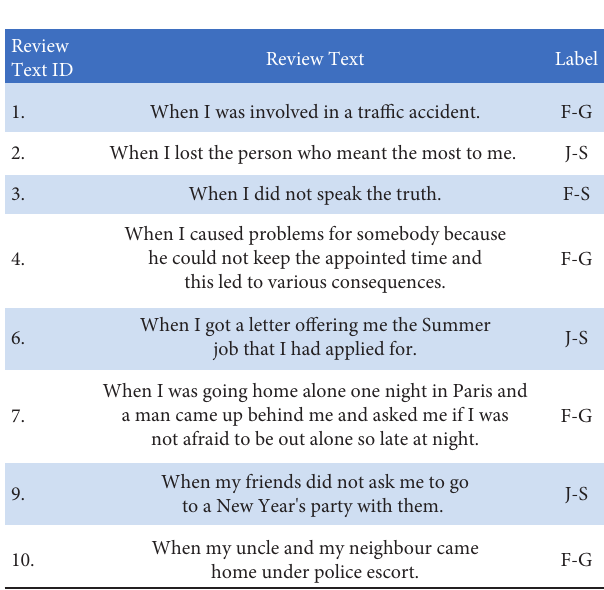
Figure 2: Train set examples for emotion